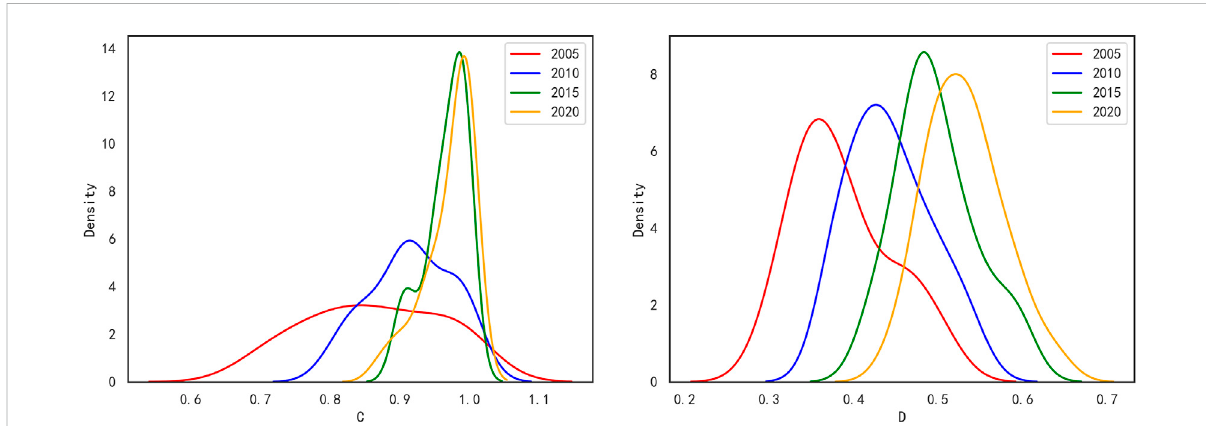
FIGURE 4 Kernel density curves of coupling and coordination degrees of HQD and RECC in 30